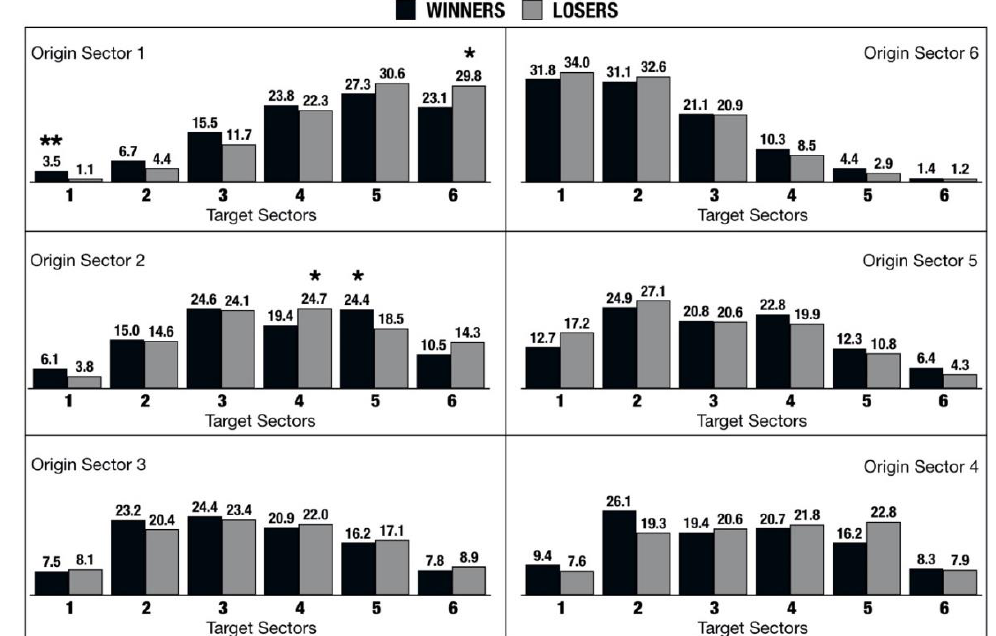
Figure 2. Comparison of mean percentage of throws for winner vs. loser. * p < .05; ** p < .01 *** p<.001. Note: in some cases, not exactly 100% due to